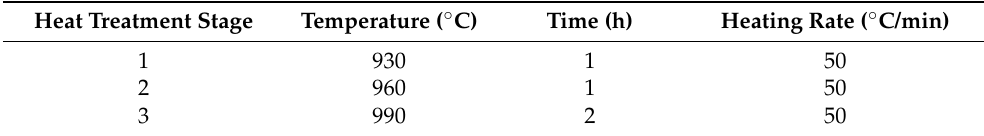
Table 2. Multistage thermal oxidation (MSHT)